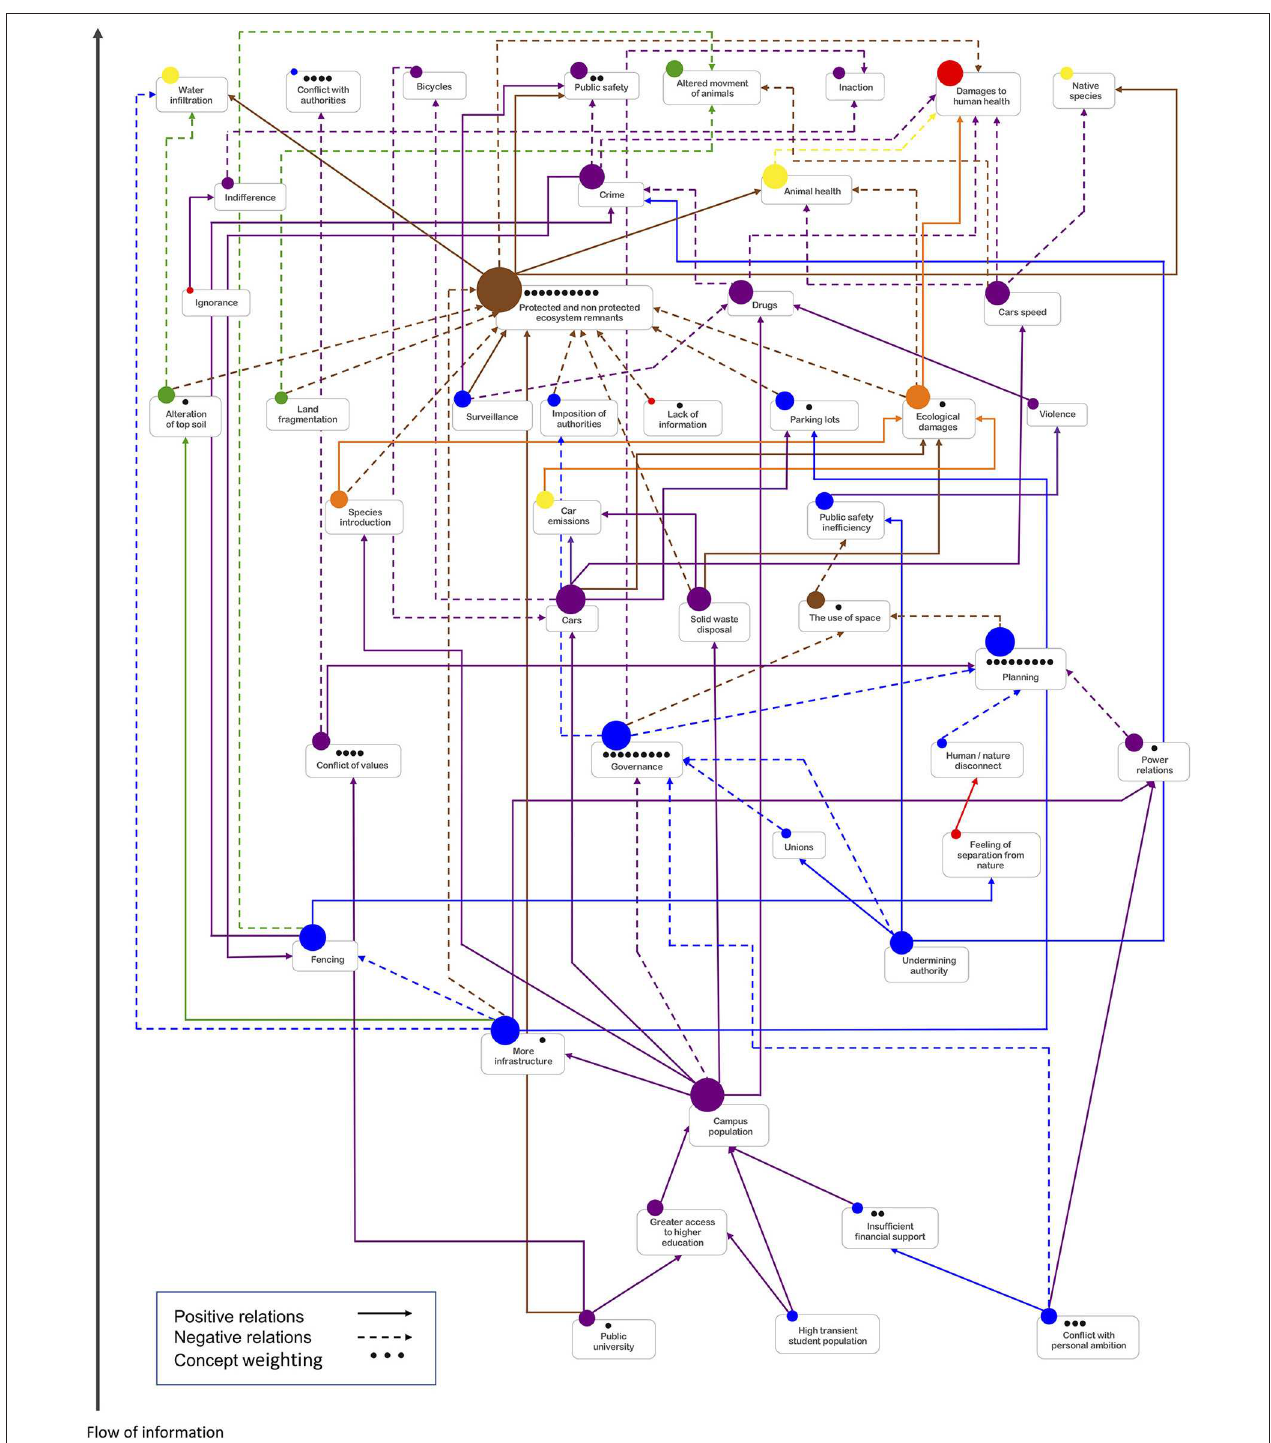
FIGURE 2 | FCM depicting the community’s perception. The color of the concepts corresponds to the different categories established: A in yellow, B in red, C in blue, whereas the subcategories A-B , A-C , B-C , and A-B-C are in orange, green, purple, and brown, respectively. Likewise, the size of the nodes is consistent with the centrality, hence, bigger nodes have more connections with other nodes, while the smallest nodes contain one edge only. The small black circles next to the concepts indicate the weighting scores, that is, the sum of the points given by each participant to those concepts considered of high relevance for the system. The concepts are connected through causal relations that are positives (solid lines) or negatives (dotted lines). The black arrow to the left depicts the flow of information from the base to the top concepts.